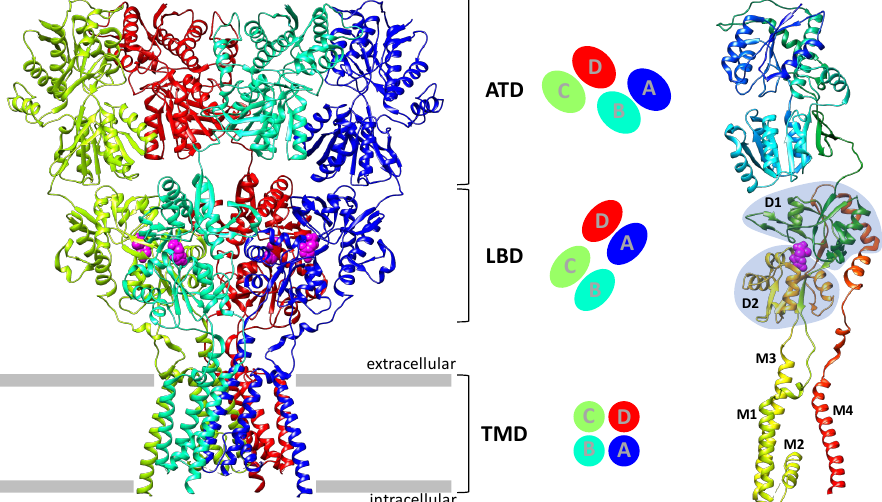
Figure 1. AMPA receptor architecture: overall receptor structure (PDB: 5VHZ) and its location in the membrane (left; individual subunits are colored blue, mint, spring green, and red); subunit contact topology and symmetry of the amino-terminal, ligand-binding, and transmembrane domains (center); structure of an individual subunit (right; backbone chain colored using “rainbow” color scheme). The location of the binding site for agonists and competitive antagonists is shown in purple; the D1 and D2 lobes of the ligand-binding domain as well as the transmembrane segments M1–M4 are marked in the subunit